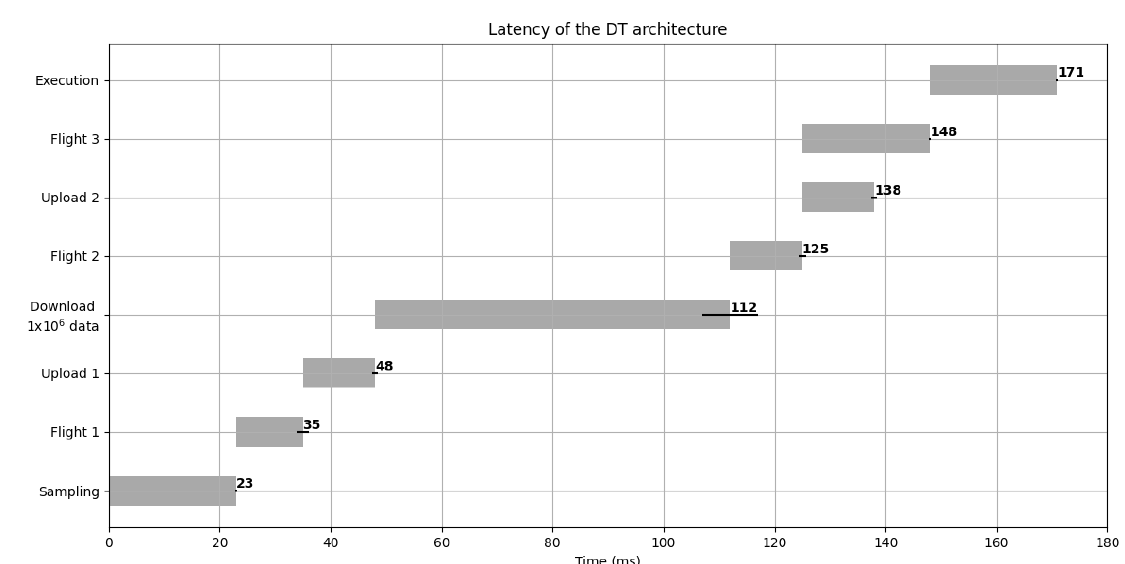
Figure 7. Timing diagram of the latency taken within each communication. Error bars quantify the uncertainty of each measurement. The nomenclature shown in Figure 6 is utilized for defining the different